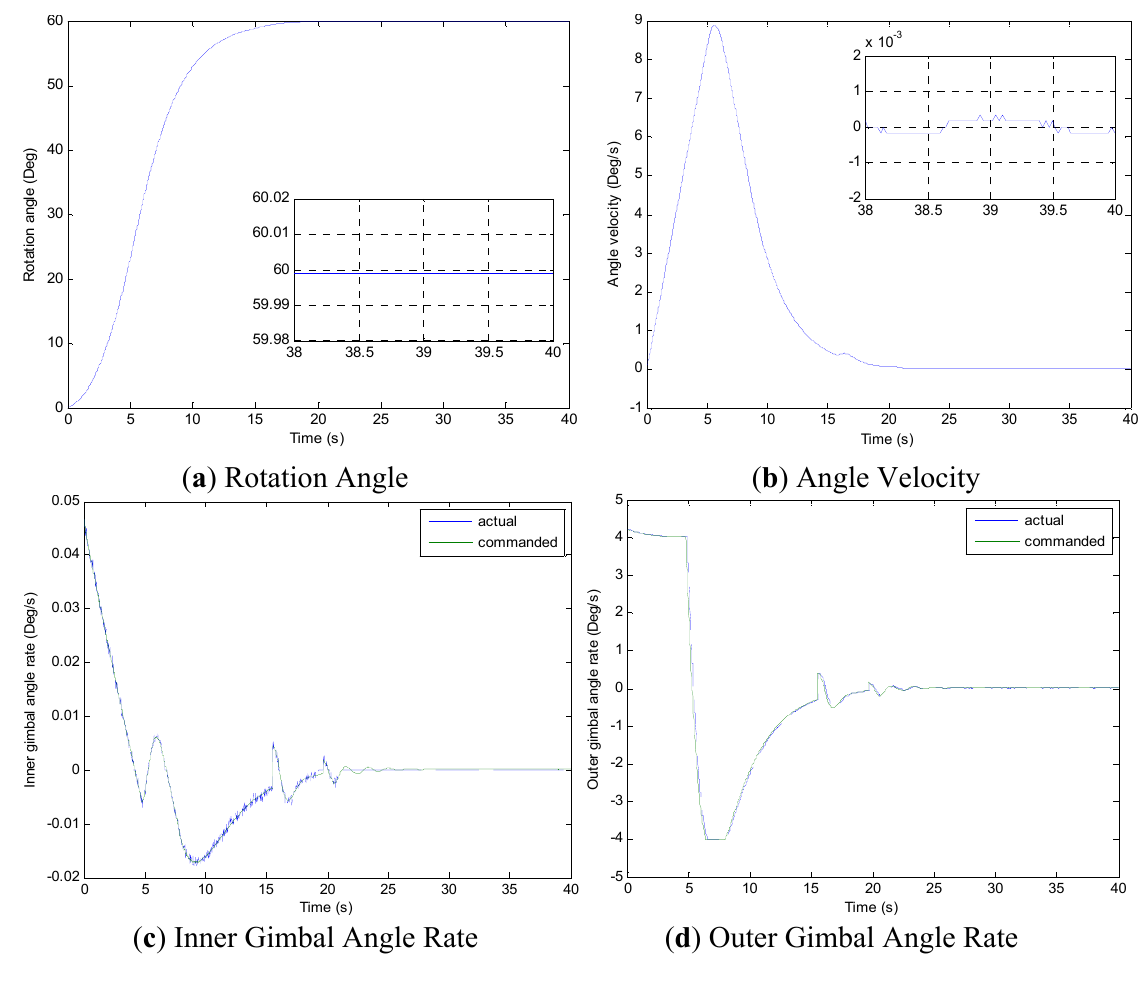
Figure 5. MSDGCMG Rotor Speed 15,000 rpm (Case